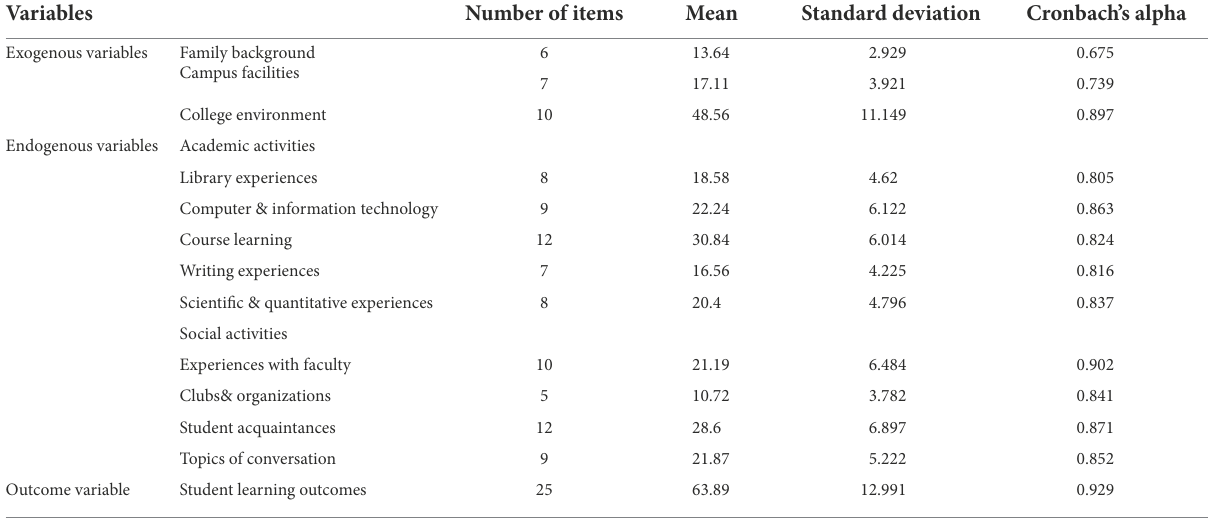
TABLE 1 Descriptive statistics for study variables.